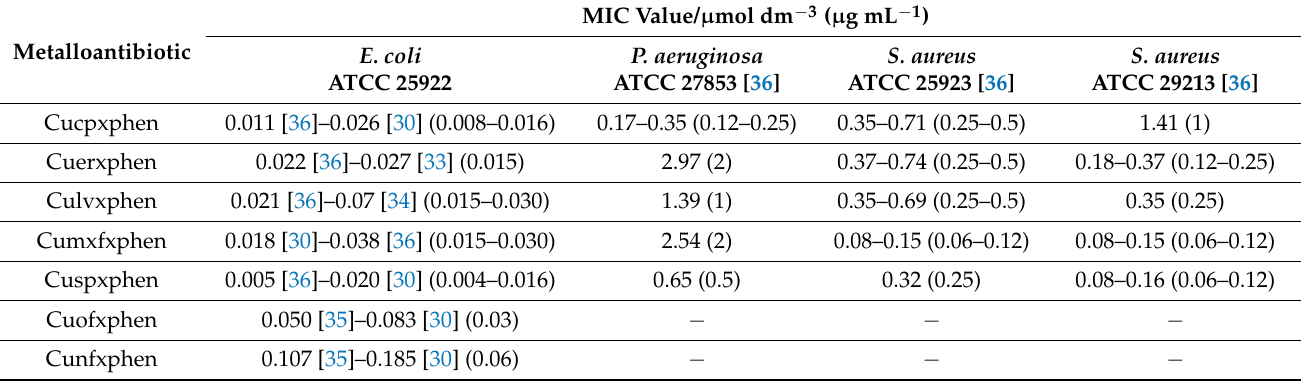
Table 4. Minimum inhibitory concentration (MIC) values of several metalloantibiotics (CuFQphen) against reference strains E. coli ATCC 25922, P. aeruginosa ATCC 27853, S. aureus ATCC 25923, and S. aureus ATCC 29213, from [30,33–36].